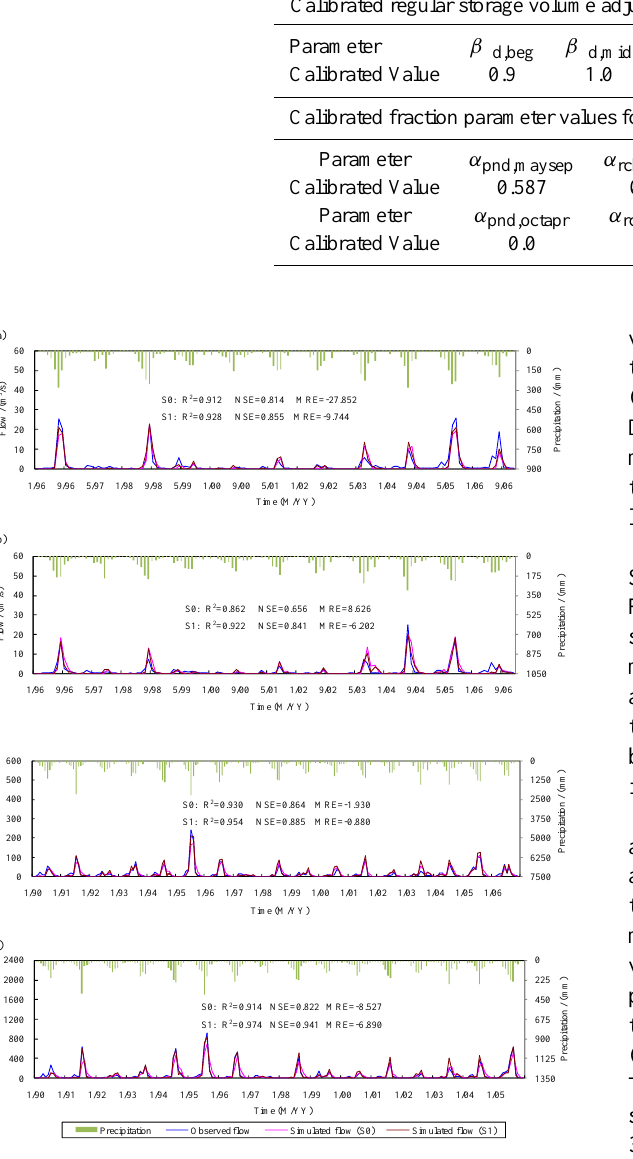
Fig. 7 Observed and simulated monthly streamflows over the validation periods at all Fig. 7. Observed and simulated monthly streamflows over the val- idation periods at all four discharge gauges: (a) Panshi (1996– four discharge gauges: (a) Panshi (1996-2006), (b) Dongfeng (1996-2006), (c) 2006), (b) Dongfeng (1996–2006), (c) Yangzishao (1990–2006) and (d) Wudaogou Yangzishao (1990-2006) and (d) Wudaogou (1990-2006).